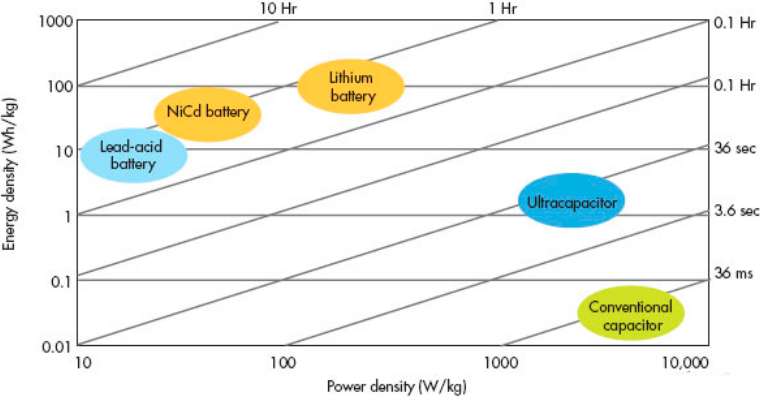
Figure 2. Ragone plot for various energy storage devices (ESDs), with diagonal discharge time (Source: ElectronicDesign.com, 15 November 2007).